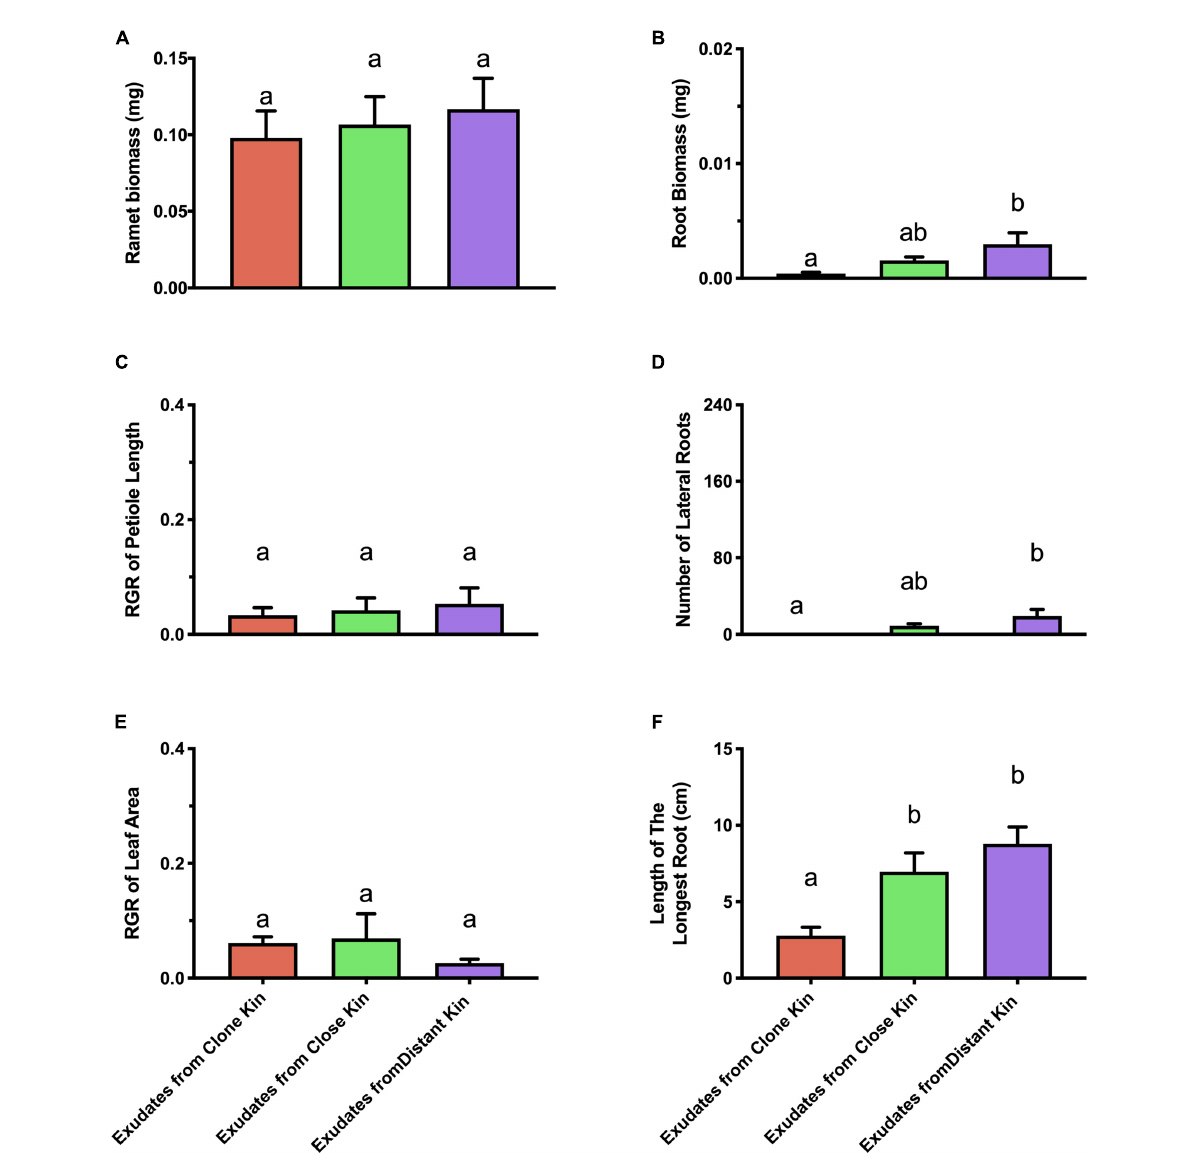
FIGURE3 Competitive traits of solitary G. longituba ramets growing with root exudates from pre-treatment under high nutrient level. (A) Ramet biomass, (B) Root biomass, (C) RGR of petiole length, (D) number of lateral roots, (E) RGR of leaf area, and (F) Length of the longest root. Bars with different letters mean significant differences at p <